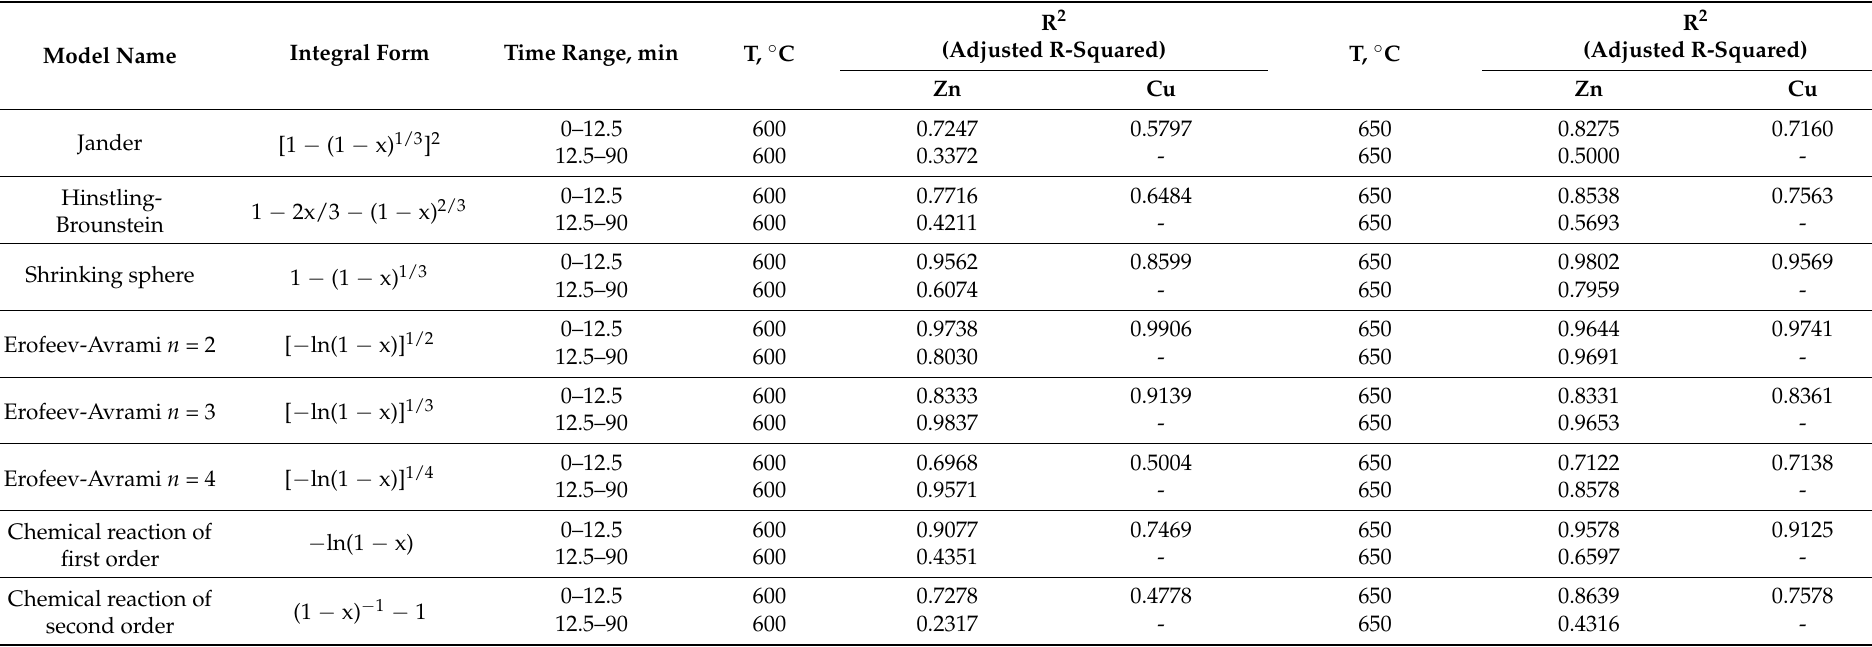
Table 7. Comparison of various kinetic models for the sulfating zinc and copper during the roasting at 600 and 650 ◦ C with the addition of 48% Fe 2 (SO 4 ) 3 · 9H 2 O to 100%